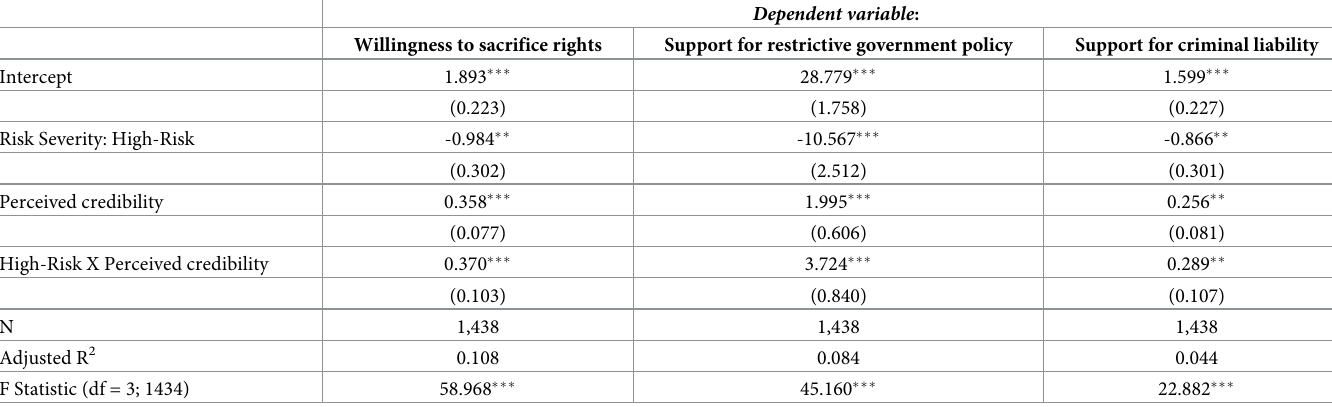
Table 10. Conditional average treatment effects of high-risk vs. low-risk